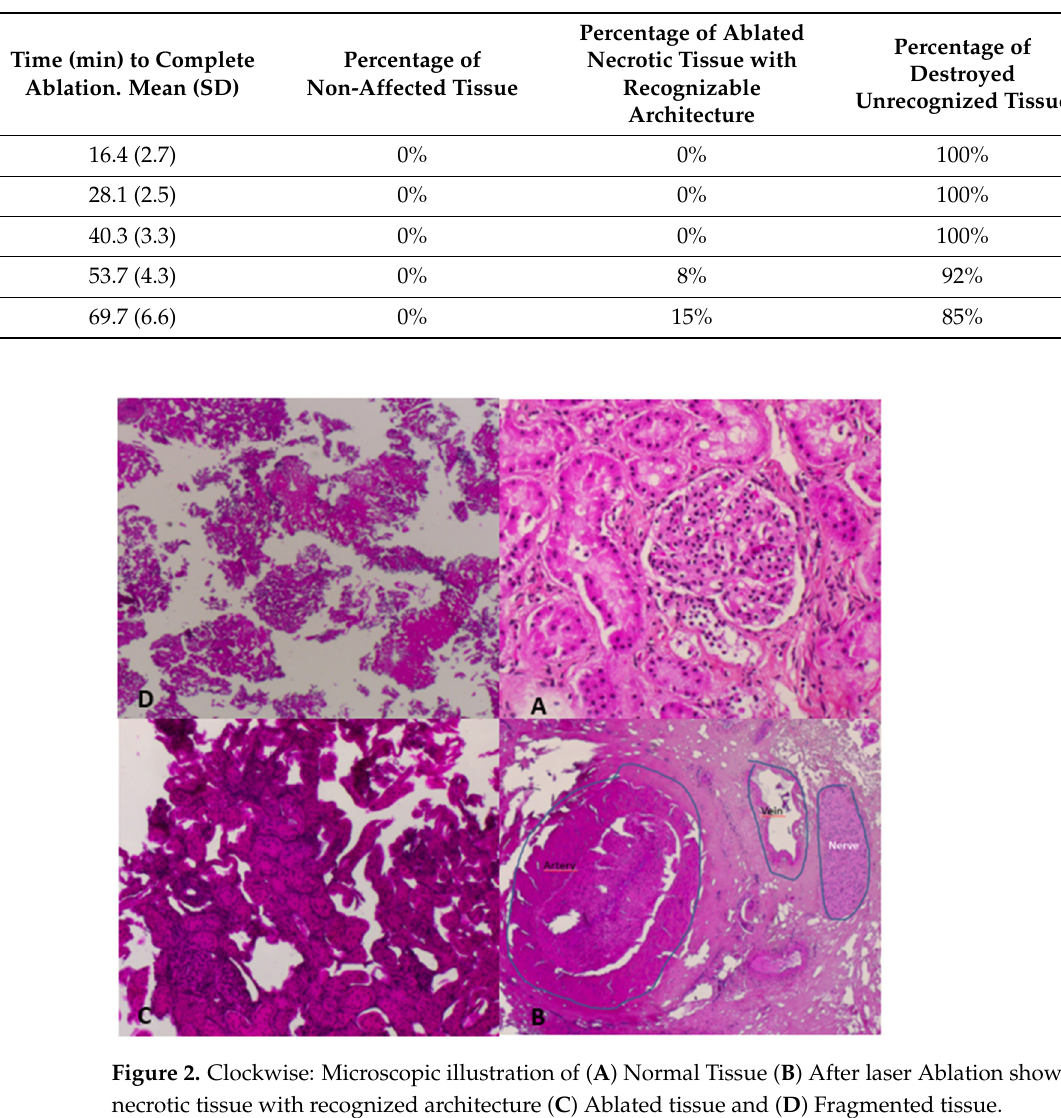
Table 1. Results of ablation time and histological analysis of ablated tissue according to tissue size.